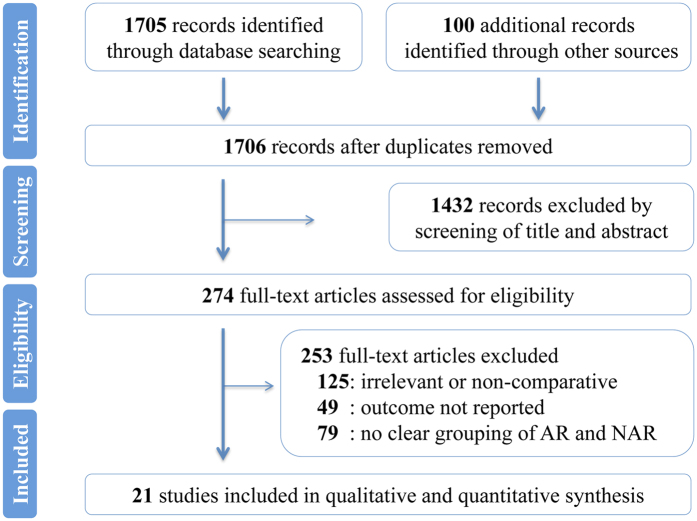
PRISMA flowchart of the study selection.